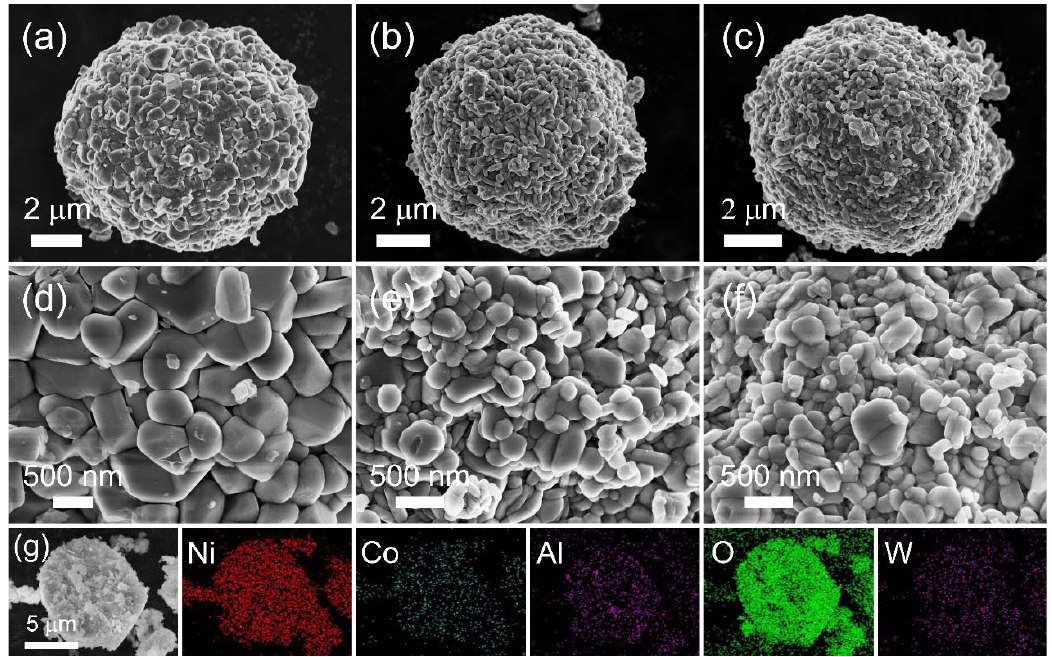
Figure 2. SEM images ( a , d ) NCA, ( b , e ) W0.5-NCA, ( c , f ) W1.0-NCA cathode materials. ( g ) Element mapping of Ni, Co, Al, O, and W for the cross-sectional of W1.0-NCA cathodes particle. XRD patterns of the NCA and W-doped NCA cathodes are displayed in Figure 3a. It indicates that both NCA and W-doped NCA have a hexagonal α -NaFeO 2 -type layered structure with R 3(cid:3364) m space group. No impurity phases can be observed, indicating that the W atoms are well inserted into the lattice of the NCA. The (006)/(102) and (108)/(110) reflections with clear peaks splitting in Figure 3b, demonstrate that the W-doping does not change the layered structure with high crystallinity of the cathodes. Rietveld refinement is conducted, and the lattice parameters of NCA, W0.5-NCA, and W1.0-NCA are presented in the appropriate Table 1 and Figure S3. During the Rietveld refinement of XRD patterns, the molecular models of W0.5-NCA and W1.0-NCA are assumed to LiNi 0.875 Co 0.09 Al 0.03 W 0.005 O 2 and LiNi 0.87 Co 0.09 Al 0.03 W 0.01 O 2 , respectively. The (003)/(104) peak intensity ratio (I (003) /I (104) ) decreases from 1.62 for NCA to 1.49 for